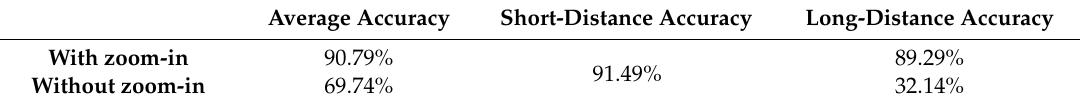
Figure 12. Recognition result without the zoom-in function (red line), where the blur rectangle indicates the individual is located far from the camera. Table 3. Recognition accuracy with and without the zoom-in method of the scenario in Figure 10.